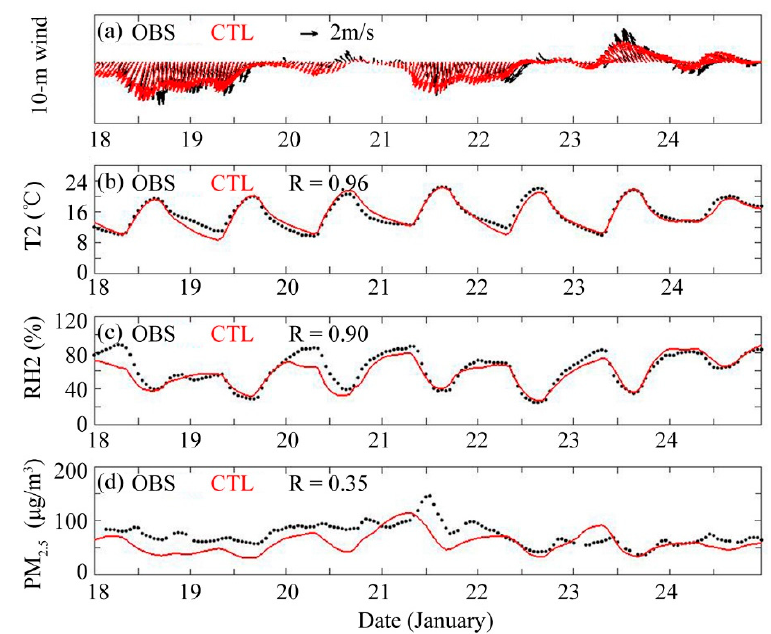
Figure 6. Time series of the simulation results of the control experiment (CTL) and observations (OBS). ( a ) 10-m wind; ( b ) 2-m air temperature (T2); ( c ) 2-m relative humidity (RH2).